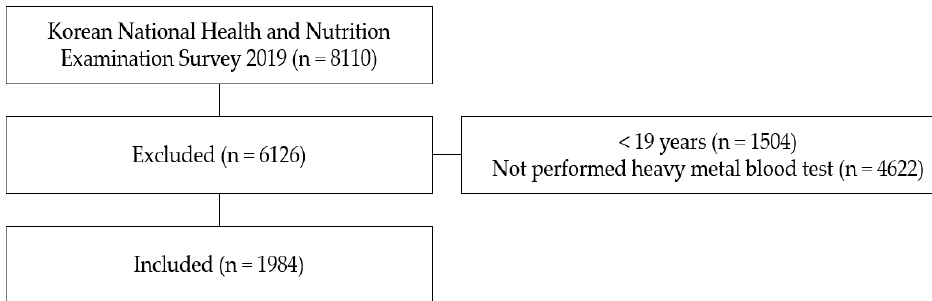
Figure 1. Simplified flow chart of study subject selection .